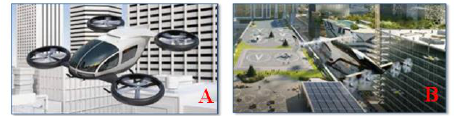
Figure 2 . Im. A: (What Is eVTOL: Electric Vertical Take-off & Landing | Spartan, 2022), Im. B: ( 未来城市空中交通展望 ,